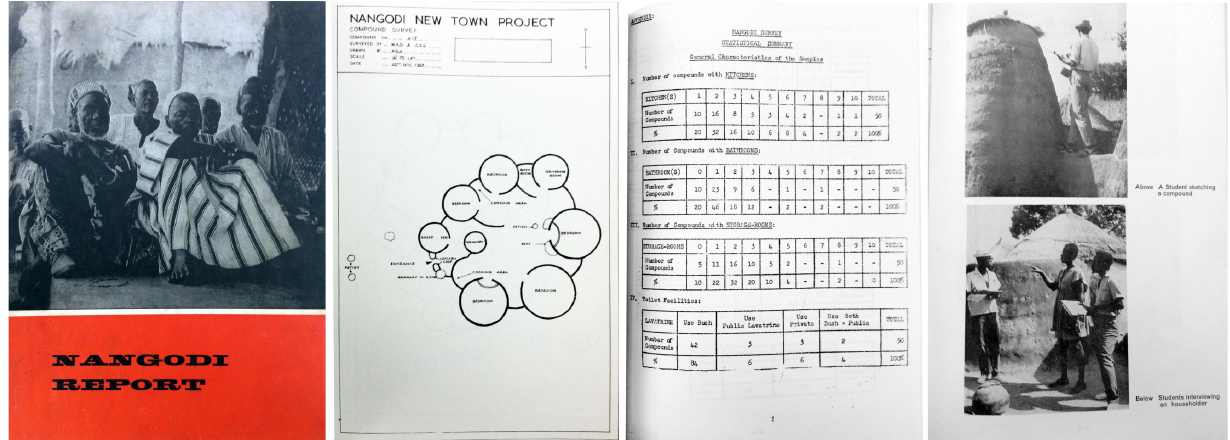
Figure 8. Nangodi Report: Occasional Report 2 . From left to right: Compound drawing; statistical summary; students sketch‐ ing a compound and interviewing a householder. Source: Lloyd et al.